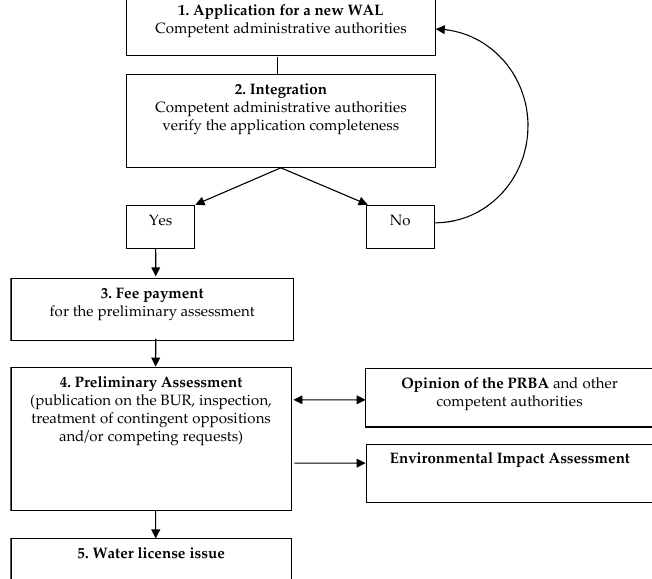
Figure 1. Administrative phases for LV and SV WAL across regions comprised in the PRBD. Source: Own elaboration .